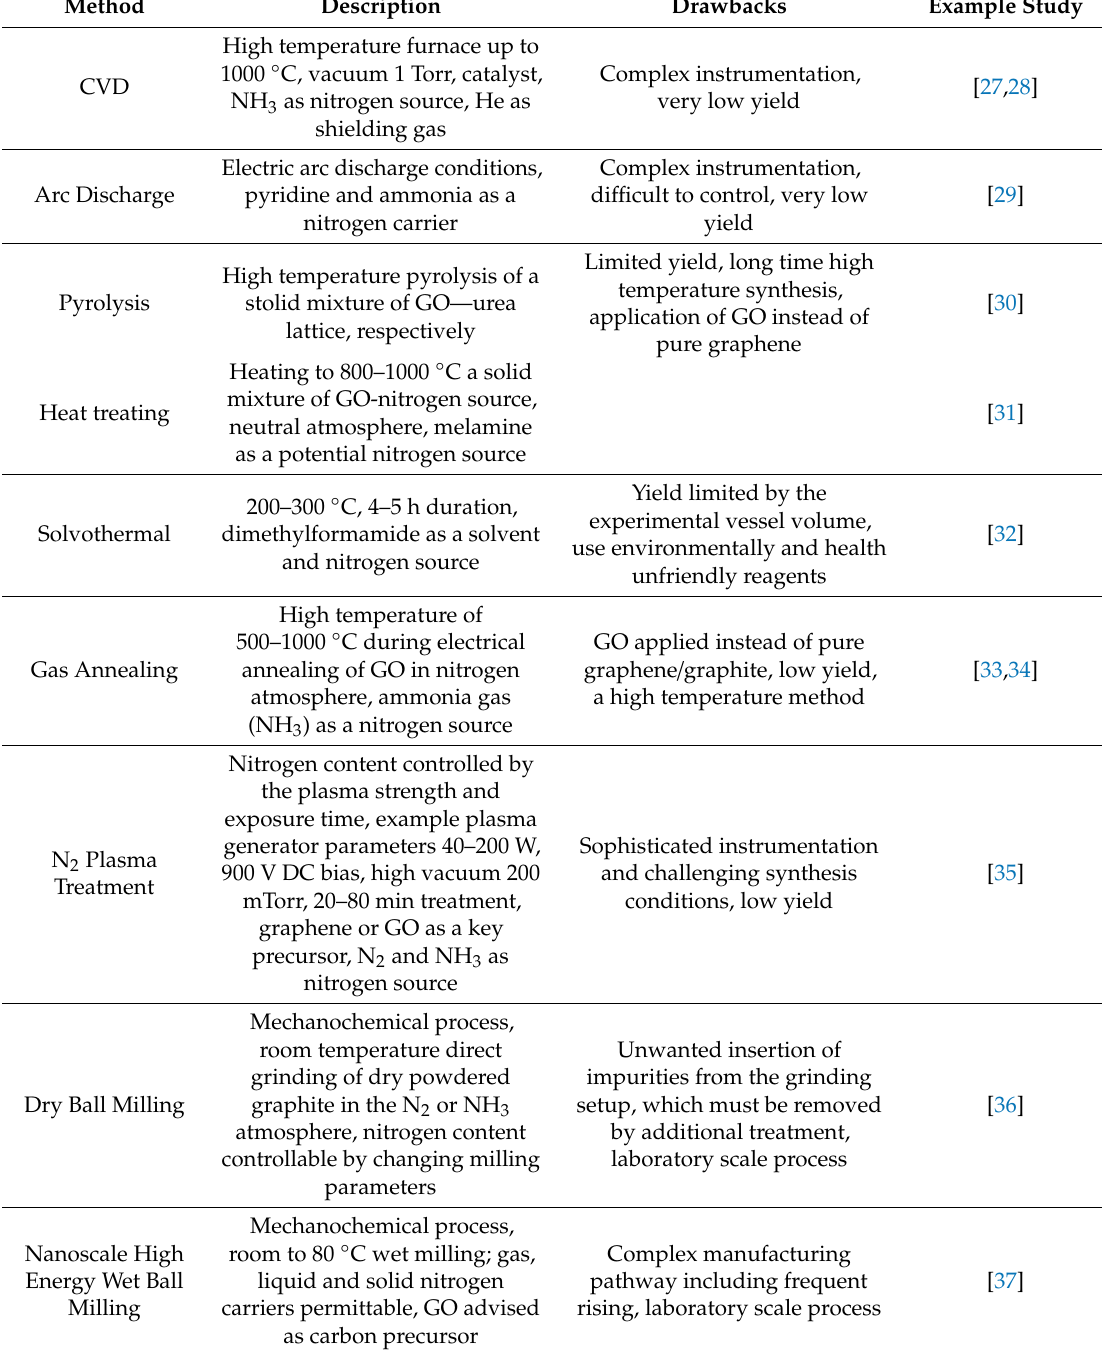
Table 1. An overview of currently practiced methods for nitrogen insertion into